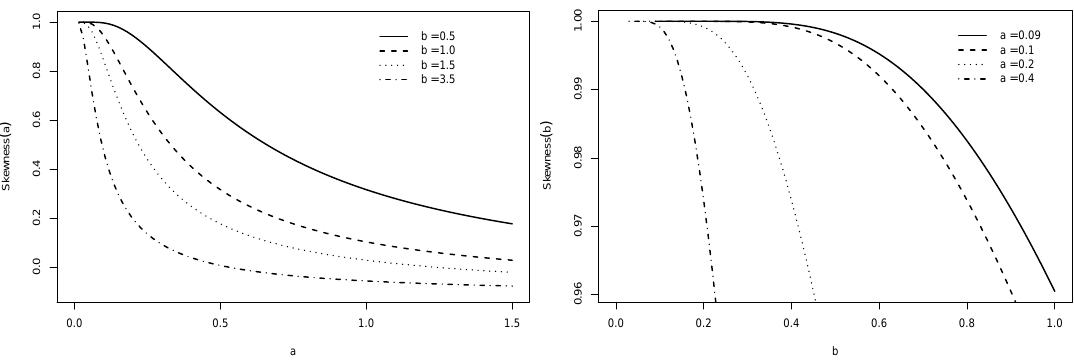
Figure 3. Plots of B for the WBP( a , b ,2.5,3) distribution: ( a ) for b fixed and ( b ) for a fixed. The behavior of the kurtosis is analogous as shown in Figures 4a,b. In Figure 4a, for any fixed value of b , the kurtosis decreases and then asymptotically approaches a constant when a increases. For b = 0.5, this behavior is slower. In Figure 4b, the kurtosis decreases and becomes asymptotically constant when b grows. For a = 0.2 and a = 0.4, this behavior happens quickly.